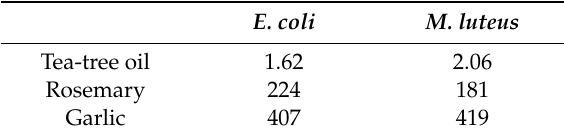
Table 1. Minimum inhibitory concentration 50 (MIC50) of the plant extracts against E. coli and M. luteus (unit: mg /